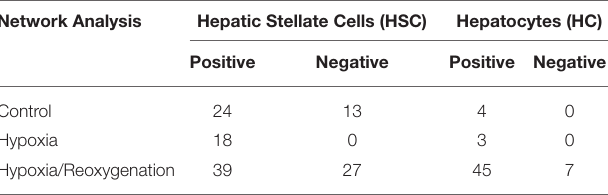
TABLE 1 | Total number of connections from Network